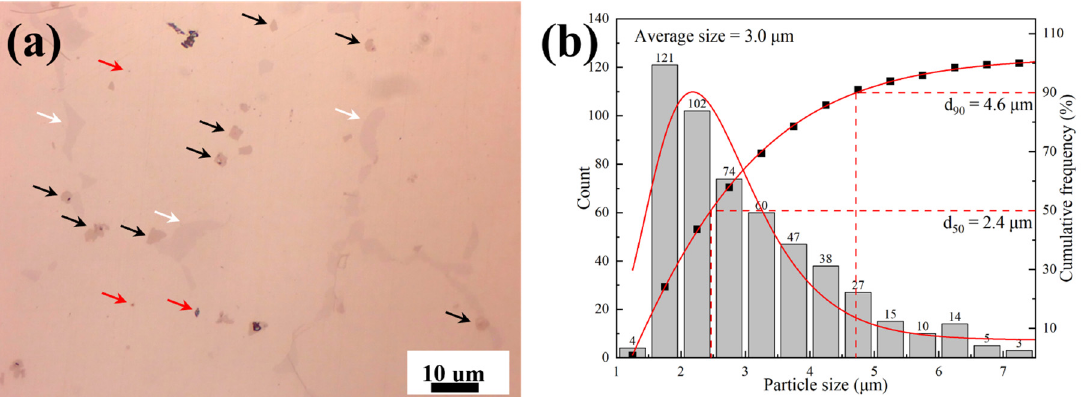
Figure 1. ( a ) OM image of as-cast GH4169 at R/2, unetched (red arrow pointing to inclusion, the black arrow pointing to MC, the white arrow pointing to the Laves phase); ( b ) histogram and cumulative frequency distribution of particle sizes at R/2 of the ingot.